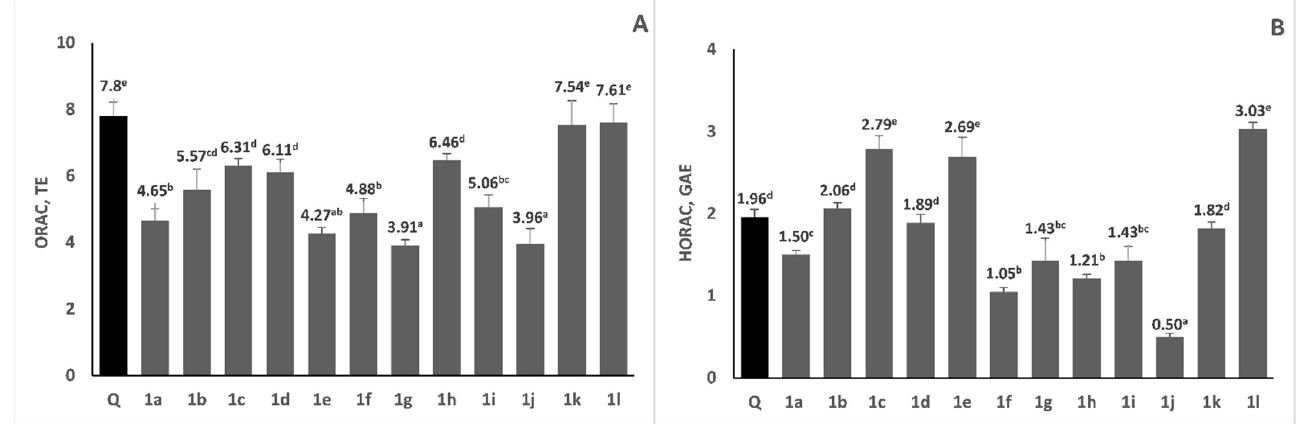
Figure 6. Antioxidant activity of compounds 1a-l measured by ORAC (panel A) and HORAC (panel B) assays. Quercetin (Q) was used as a reference compound. Results are presented as mean values ± standard deviation (SD). There are no significant differences among values marked with the same superscript letters ( p < 0.05).